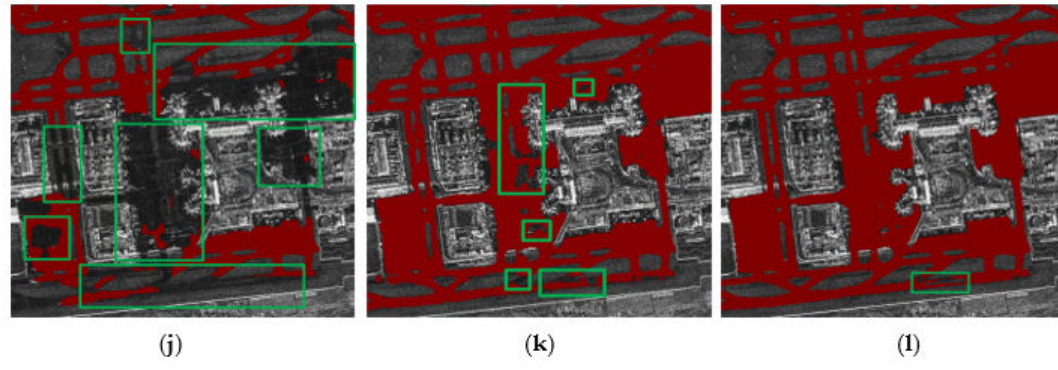
Figure 13. The enlarged view of a small part of Airport I. ( a ) SAR image of a part of Airport I from Gaofen-3. ( b ) The down-sampled SAR image of ( a ) by 5 times. ( c ) The ground truth of the airport for ( b ). ( d ) The extraction result of (b) by RefineNet. ( e ) The extraction result of ( b ) by DeepLabV3. ( f ) The extraction result of ( b ) by MDDA. ( g ) The fusion map of ( d , b ). ( h ) The fusion map of ( e , b ). ( i ) The fusion map of ( f , b ). ( j ) The fusion map of ( a , d ) up-sampled by 5 times. ( k ) The fusion map of ( a ) and ( e ) up-sampled by 5 times. ( l ) The fusion map of ( a , f ) up-sampled by 5 times.